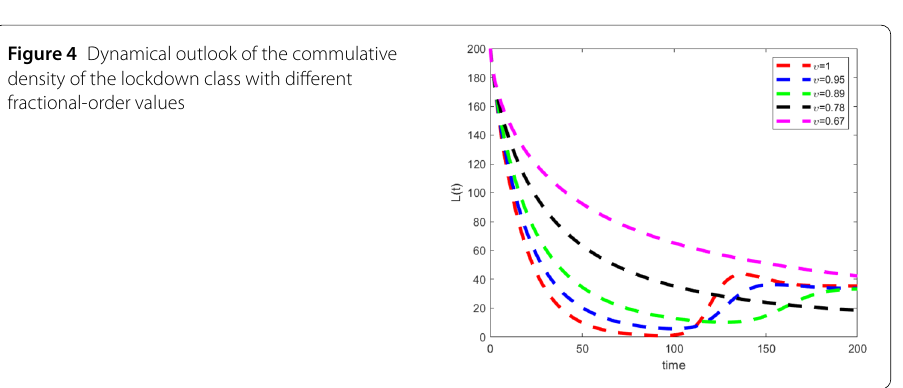
Figure 4 Dynamical outlook of the commulative density of the lockdown class with different fractional-order